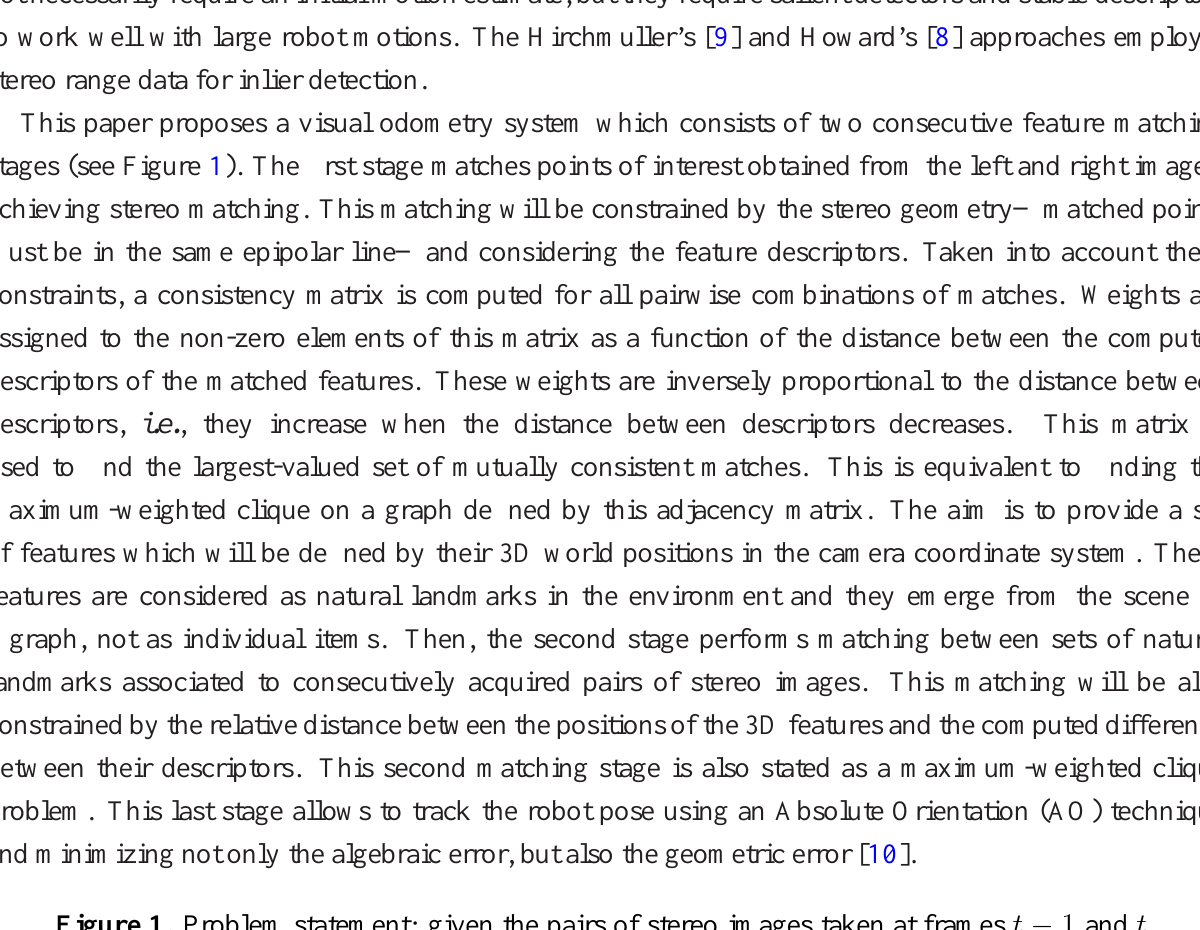
Figure 1. Problem statement: given the pairs of stereo images taken at frames t − 1 and t , the robot motion is estimated from the natural landmarks { L } i . Two graphs emerge from the stereo and feature matching